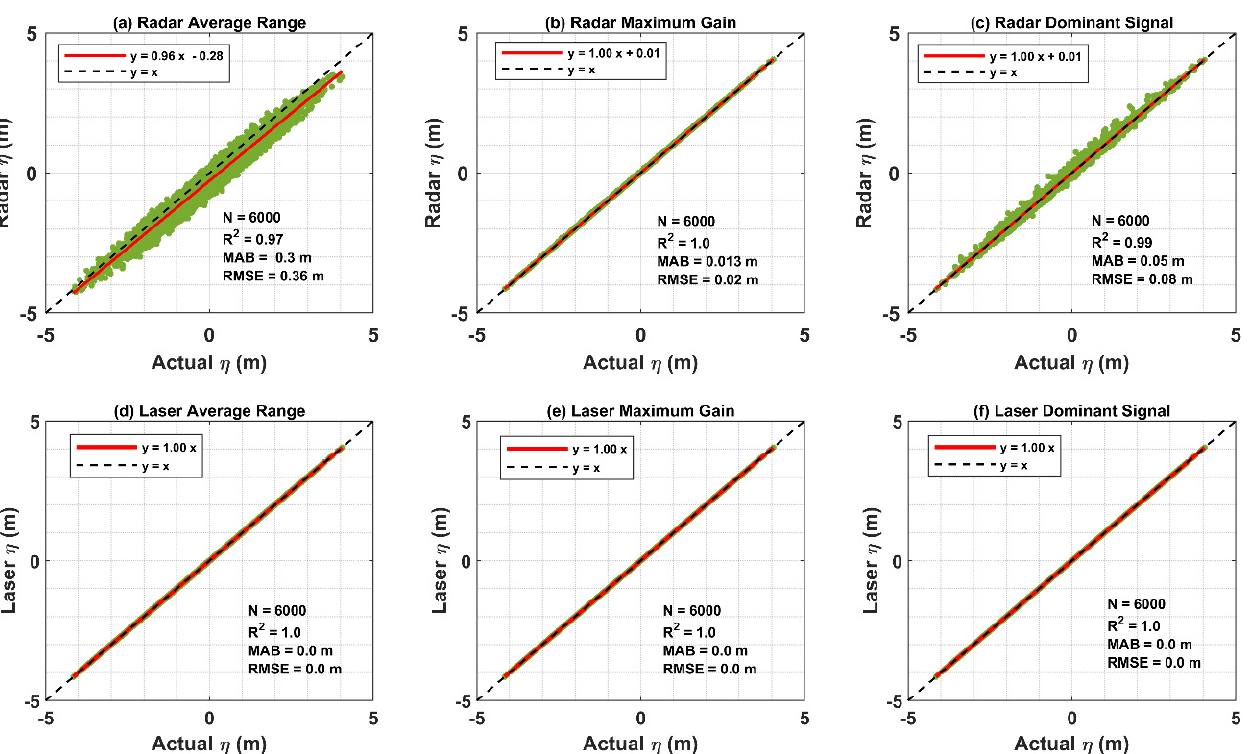
Figure 2. JONSWAP one-dimensional frequency spectrum ( a ), frequency-direction spectrum ( b ), and directional spreading ( c ). The color contours represent spectral energy density in m 2 Hz − 1 deg − 1 .